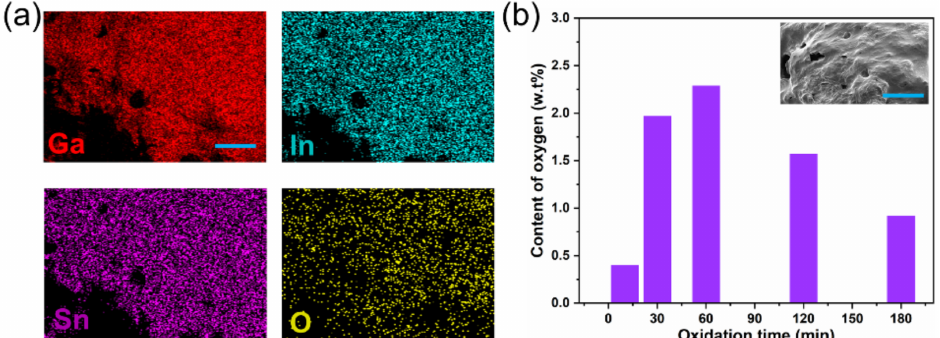
Figure 2. ( a ) The element distribution of oxidizing liquid metal. ( b ) The mass weight of oxygen in different stirring times (scale bar is 100 µ m).